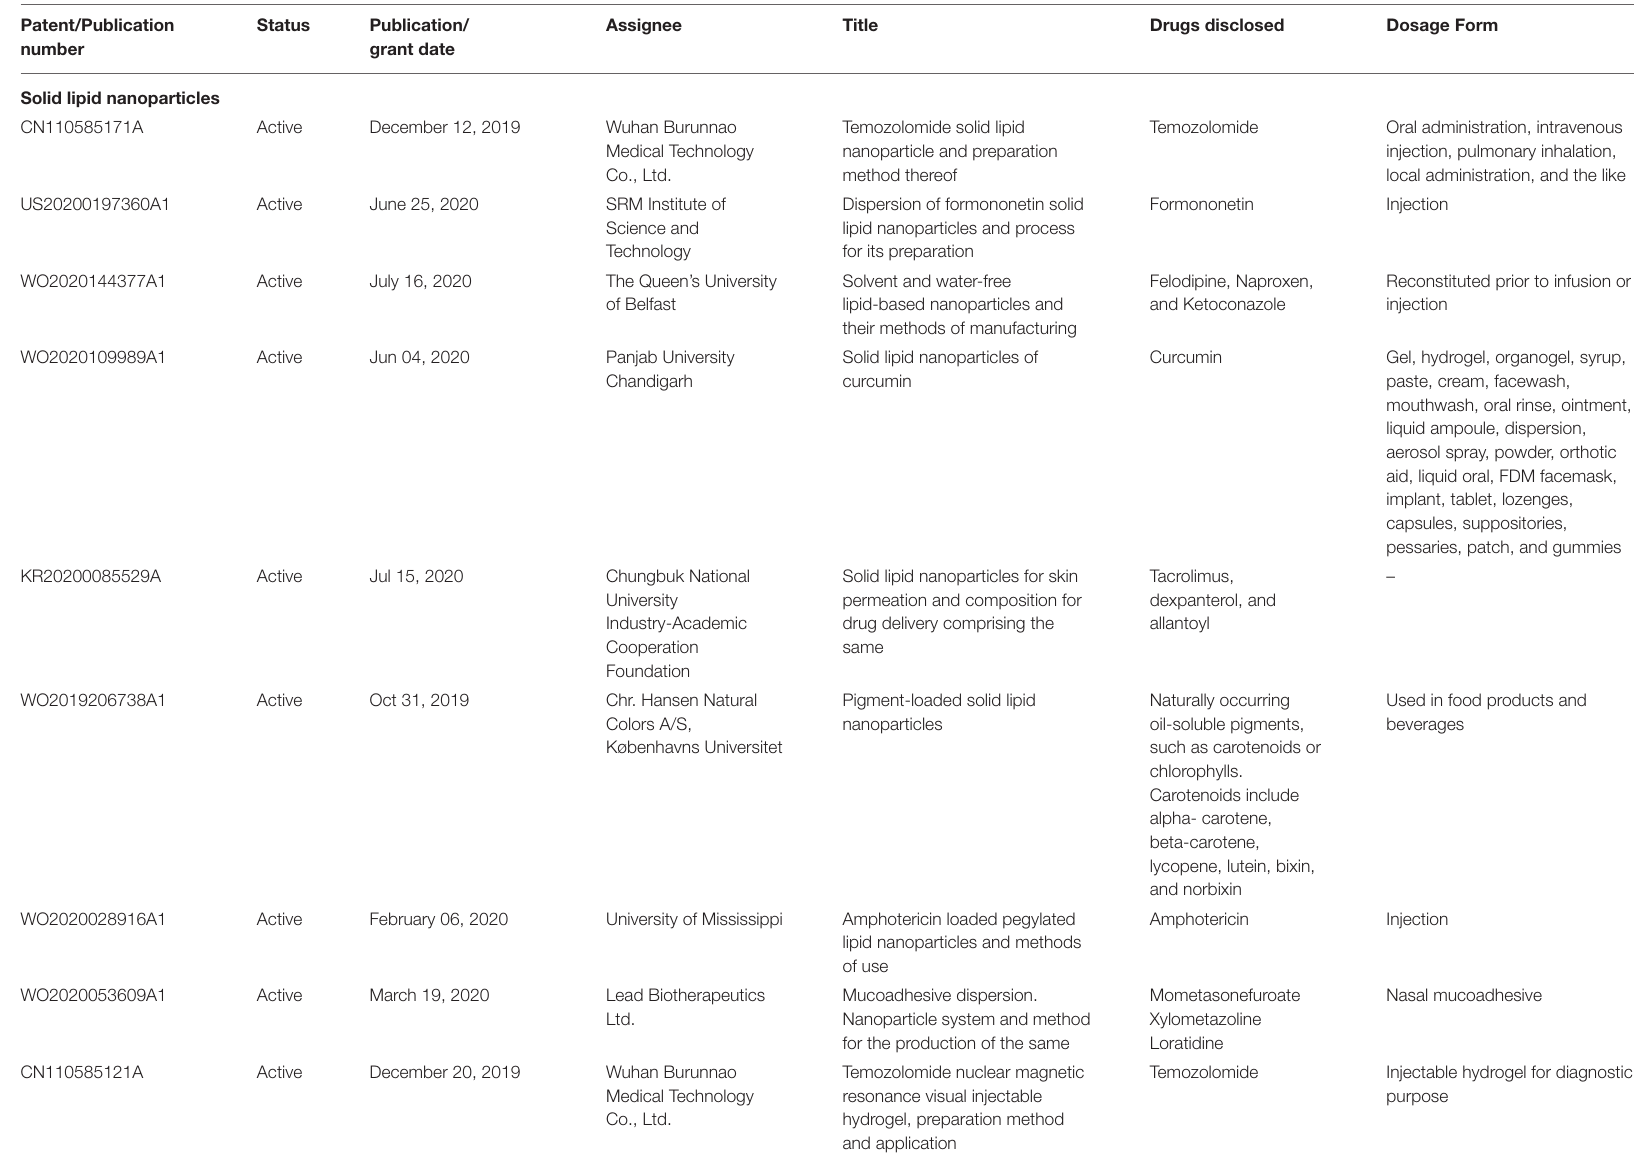
TABLE 3 | Recent patents on SLNs and